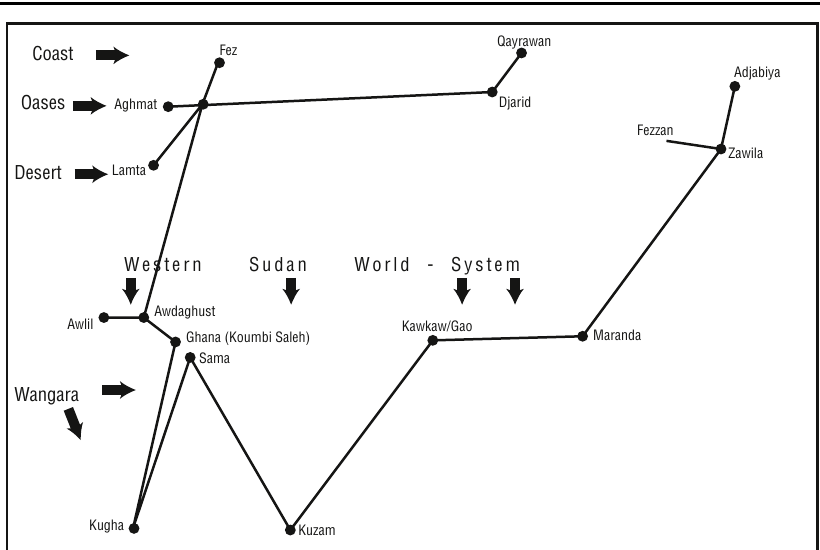
Figure 11 – Western Sudan interaction networks according to ibn Hawqal's description (10t